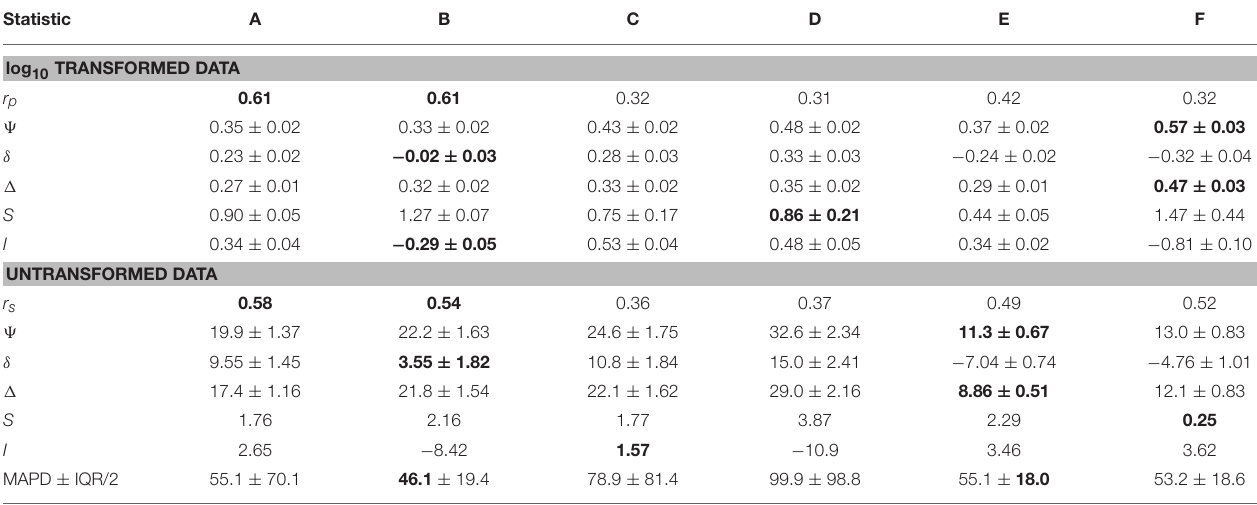
TABLE 3 | Summary of statistics of algorithm performance (algorithms A–F, columns) for log 10 and untransformed data ( N = 557). Statistic